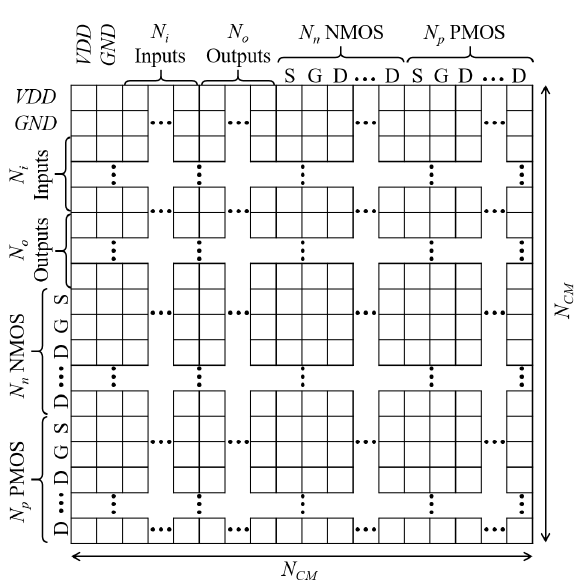
Figure 2. Connection matrix ( CM )